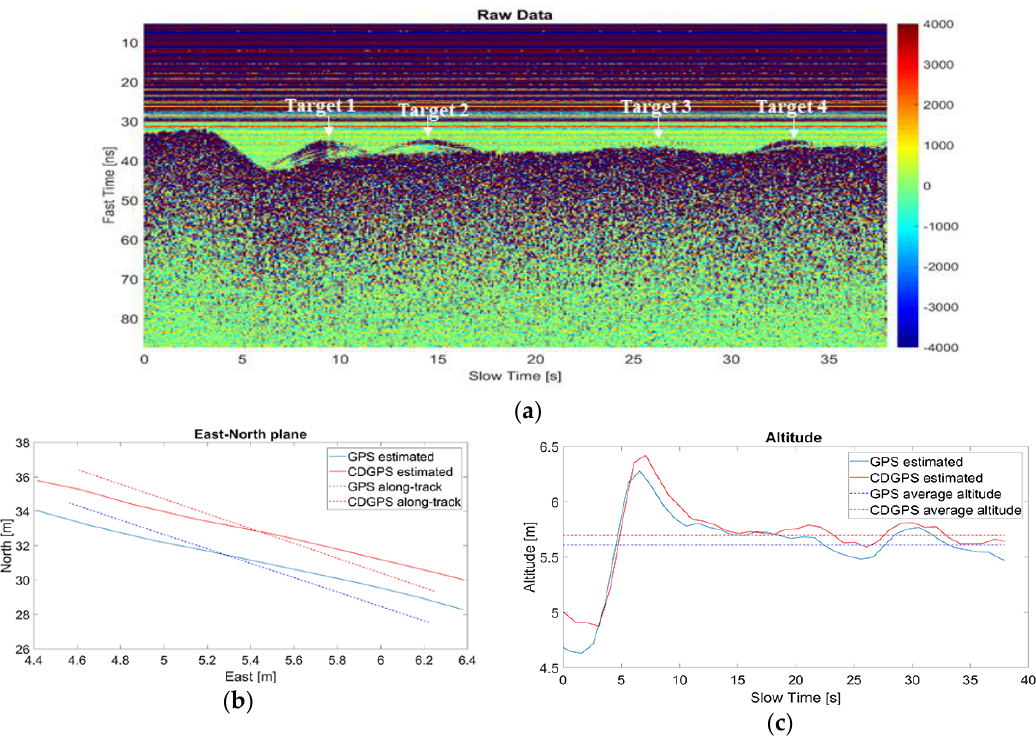
(solid red line), average altitude defined by GPS (dashed blue line) and CDGPS (dashed red line).